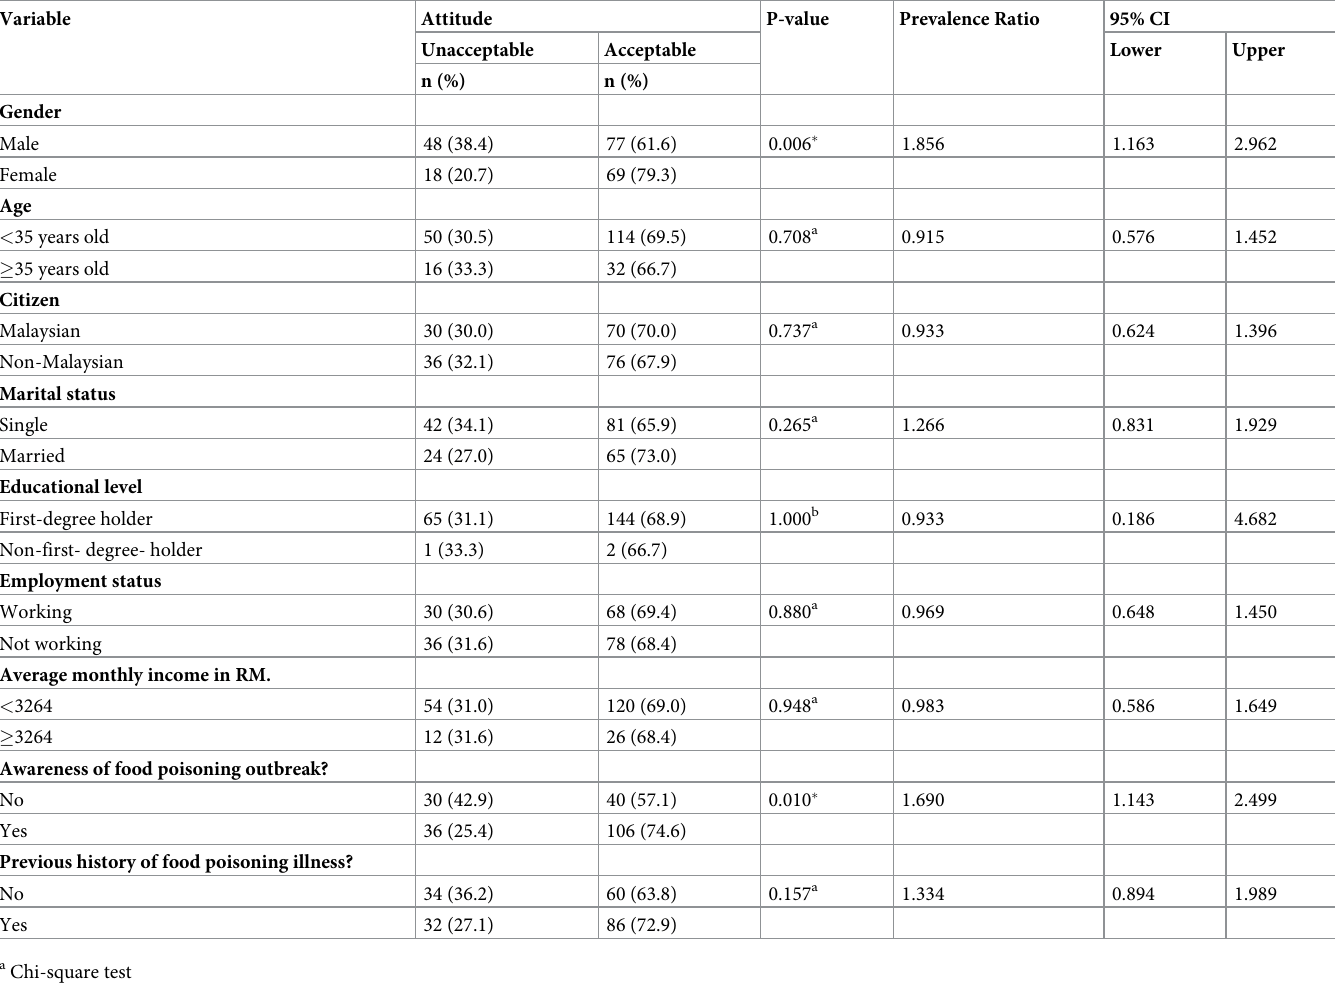
Table 12. Association of demographic and socioeconomic factors, awareness of food poisoning outbreak, and previous history of food poisoning illness with atti- tude towards food poisoning among the respondents (N = 212).